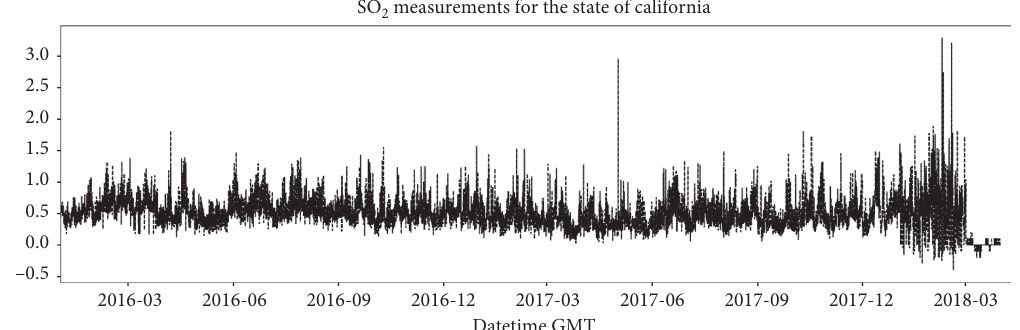
Figure 2: Sulfur dioxide measurements for the state of California.